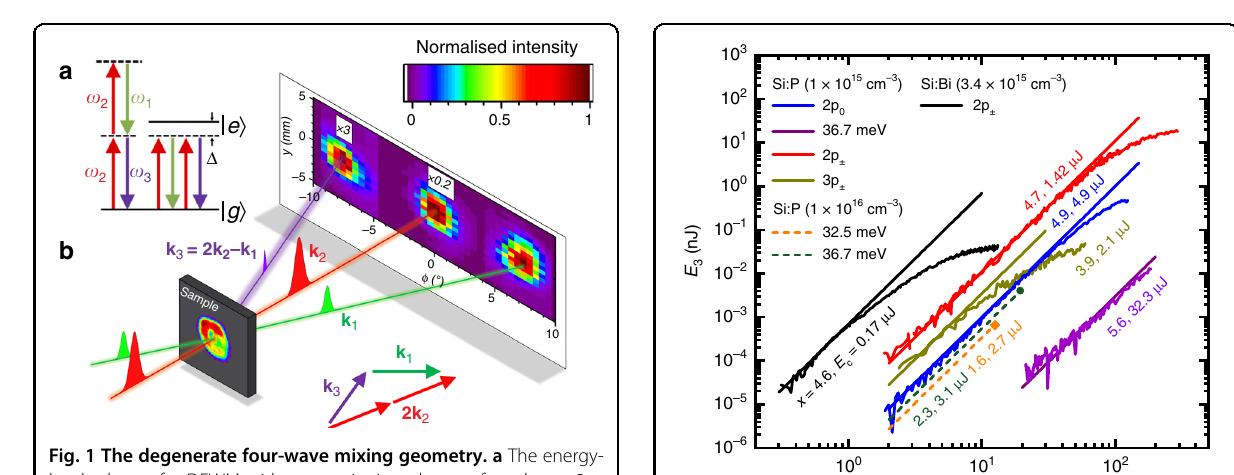
Conversion of E to χ (3) c Away from resonance and in the limit of long pulses, the relationship between E (given on Fig. 2) and χ (3) has a c straightforward dependence on the geometry and pulse duration. For short pulses, the dynamics are important,